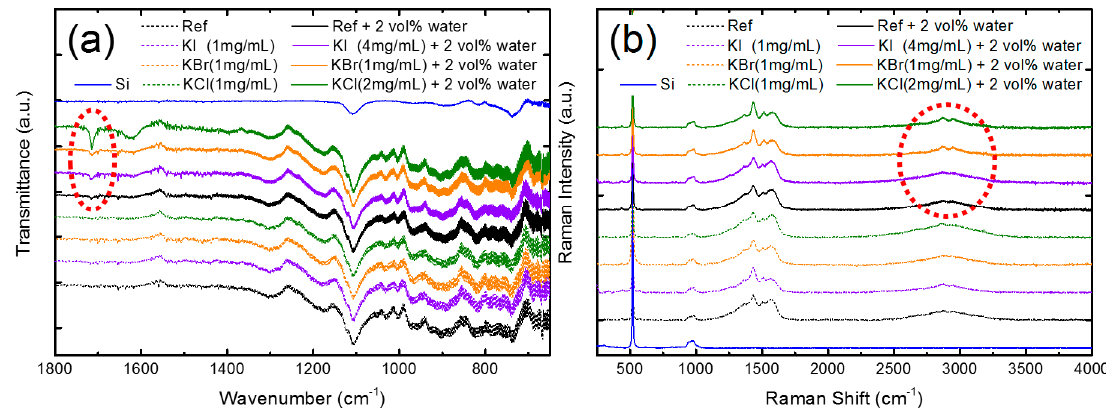
Figure 6. ( a ) Fourier transform infrared (FTIR) and ( b ) Raman spectroscopies of PbI 2 films doped using potassium halides with and without water.